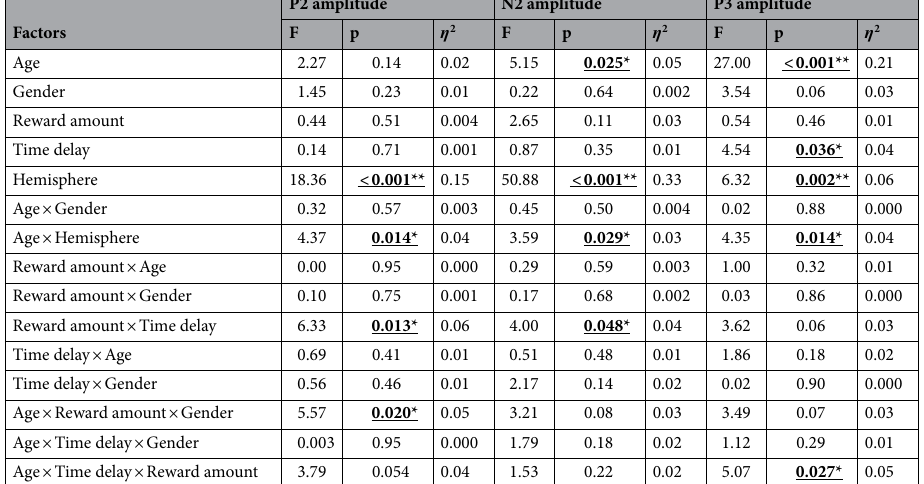
Table 6. Main and interaction effects in ANOVA analyses for ERP amplitudes. *Significance ≤ 0.05; **Significance ≤ 0.01.